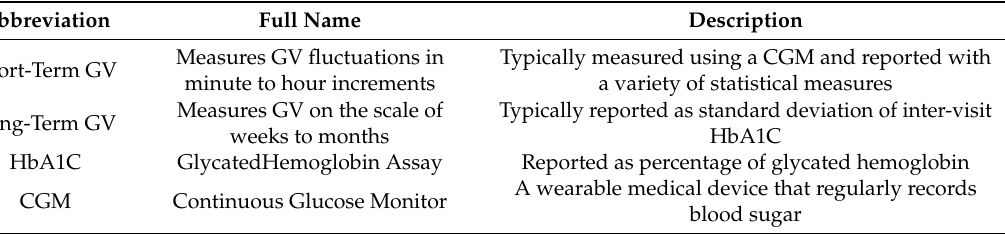
Table 1. For a more thorough review of GV metrics, see Rodbard 2009 [11] and Umpierrez 2018 [12]. Table 1. Common terms used in the study of glycemic